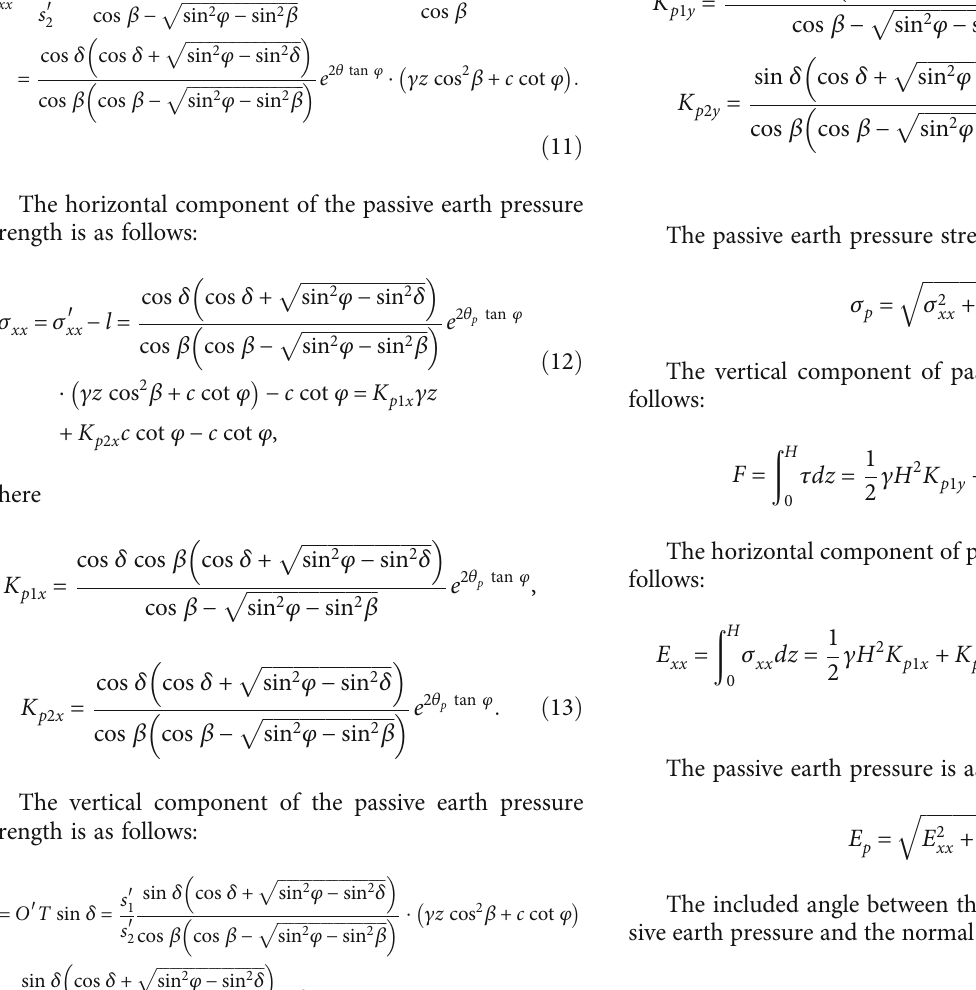
p(cid:5) ffiffiffiffiffiffiffiffiffiffiffiffiffiffiffiffiffiffiffiffiffiffiffiffiffi sin 2 φ − sin 2 δ p ffiffiffiffiffiffiffiffiffiffiffiffiffiffiffiffiffiffiffiffiffiffiffiffiffiffi sin 2 φ − sin 2 β p(cid:5) ffiffiffiffiffiffiffiffiffiffiffiffiffiffiffiffiffiffiffiffiffiffiffiffiffi sin 2 φ − sin 2 δ p(cid:5) ffiffiffiffiffiffiffiffiffiffiffiffiffiffiffiffiffiffiffiffiffiffiffiffiffiffi sin 2 φ − sin 2 β